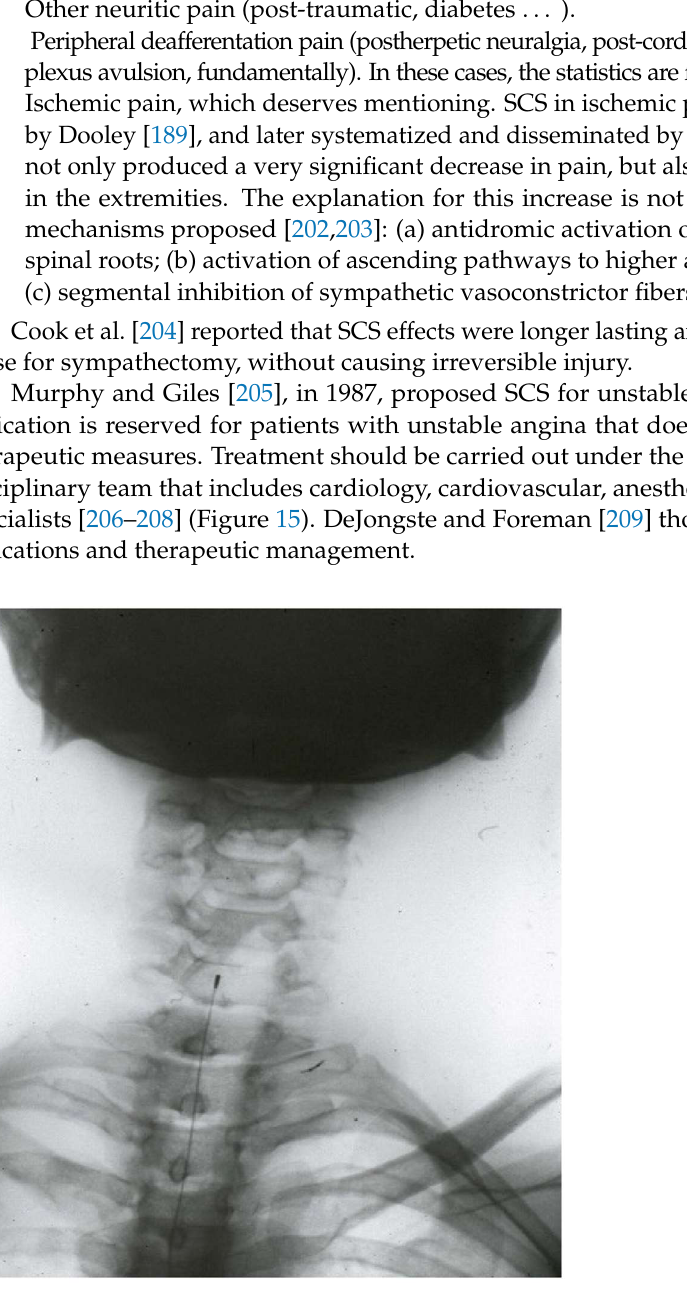
Figure 15. Cervical stimulation in a patient with unstable